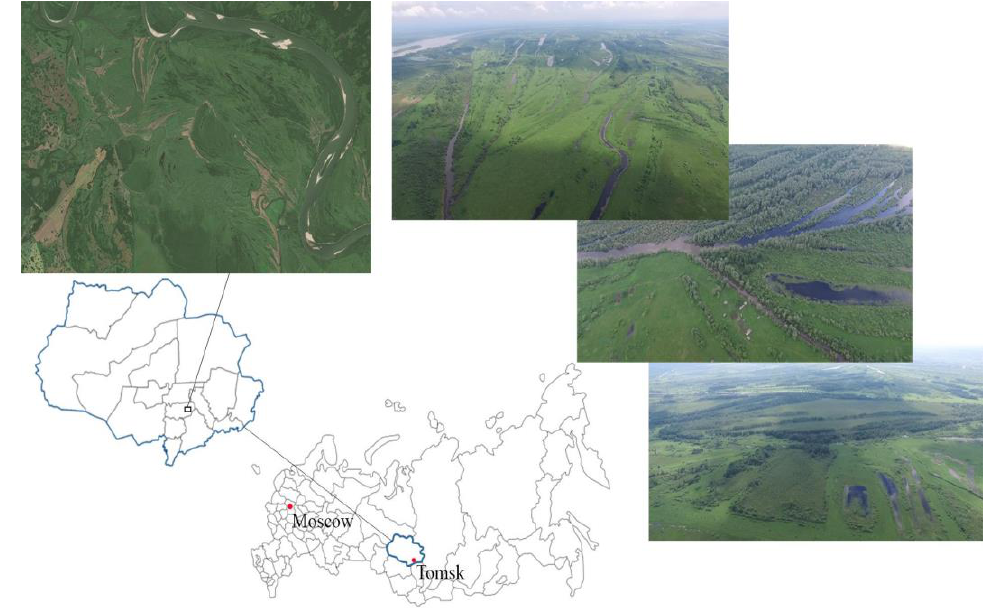
Figure 1. Drone views of study area.